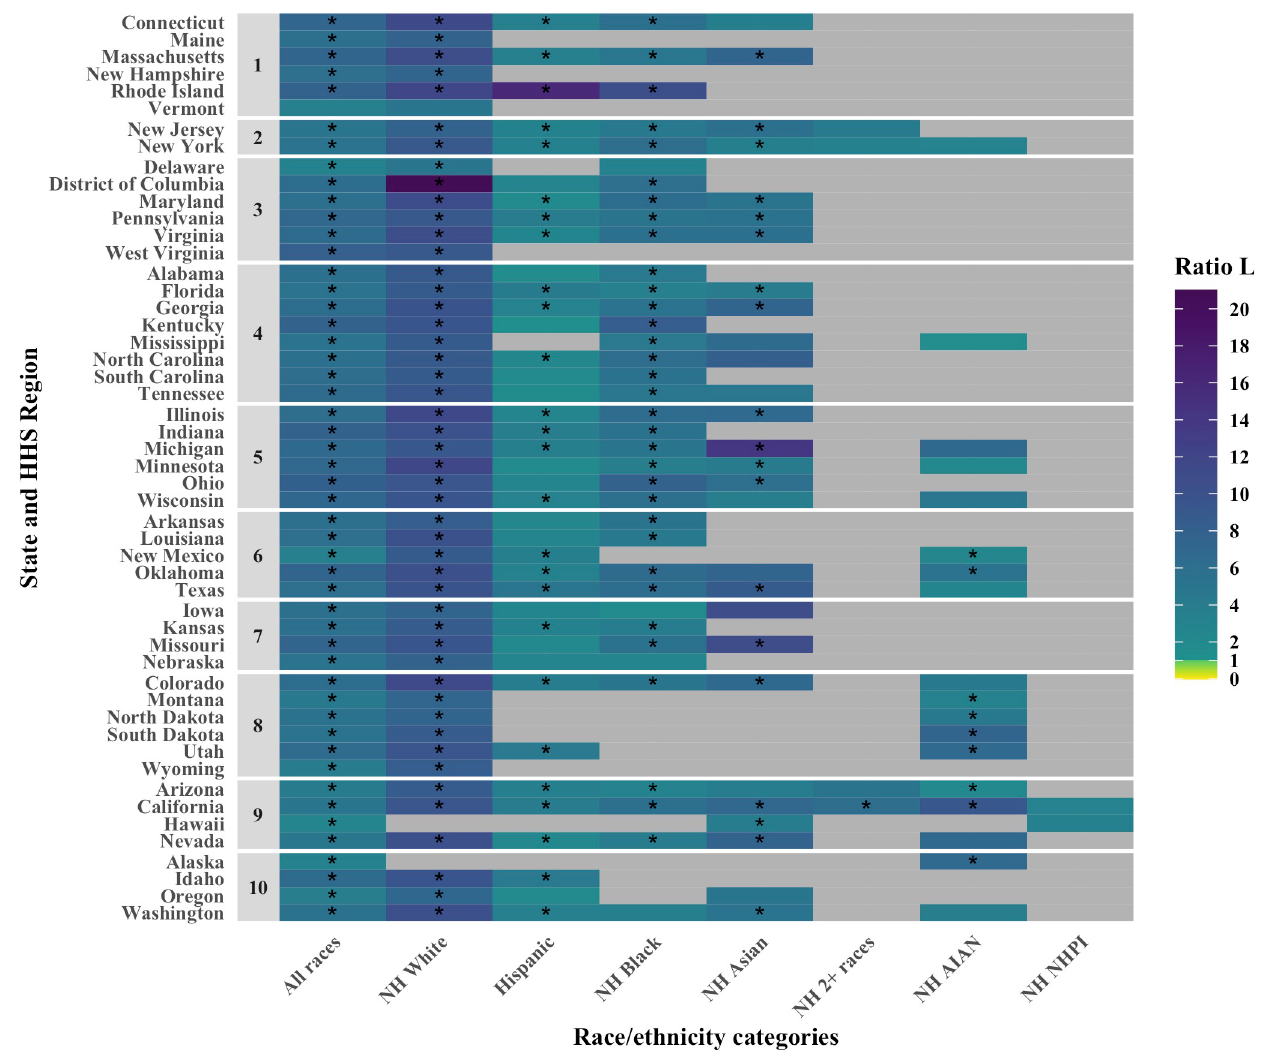
Fig 1. Comparative performance of policies S and F (shown in the form of a ratio L = LS j of Columbia in terms of lives saved. States are grouped by HHS Region. Stars indicate the race/ethnicity/state for which the lower bound of the 95% interval did not include 1.